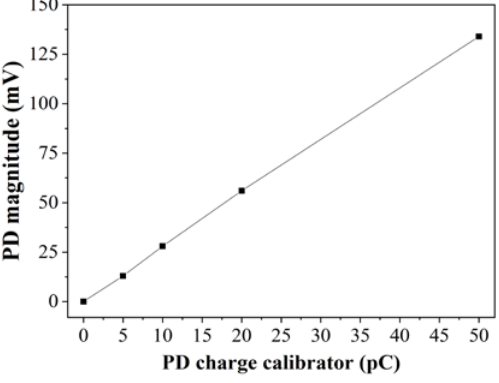
Figure 4. IMC reading based on charge